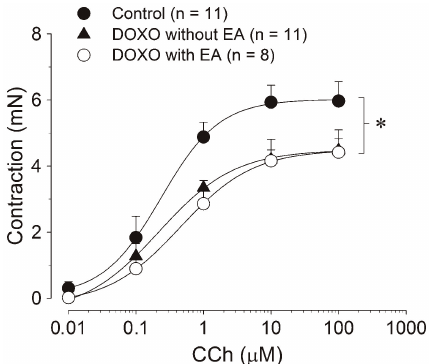
Figure 1. Comparison of the effect of carbachol (CCh) on the distal esophagus of fetus with esophageal atresia (EA). The graph shows the mean tension of the distal esophageal strips in response to increasing concentrations of CCh (0.01-100 m M). The tension was verified considering difference in peak and the amplitude expressed in mN. Data are reported as means±SE. DOXO: doxorubicin. *P , 0.05, treated groups compared to controls (two-way ANOVA, followed by a Student-Newman- Keuls